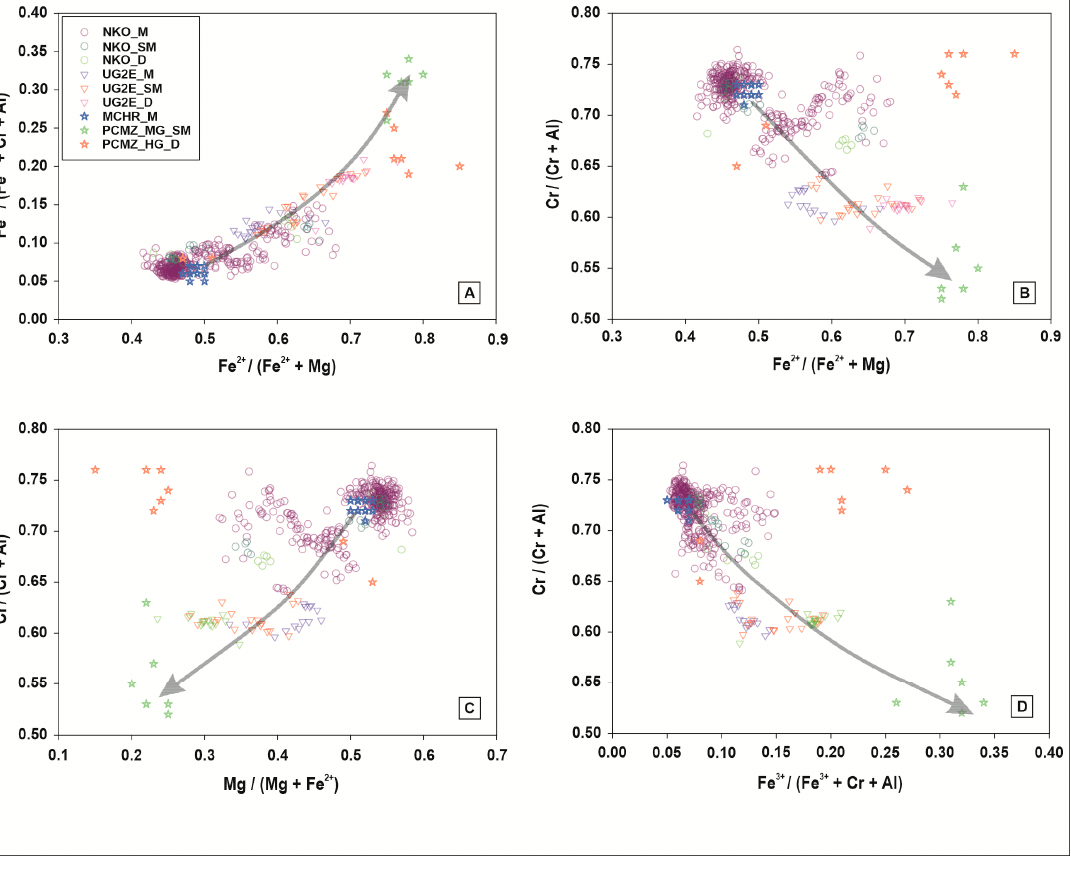
Figure 4. Binary diagrams of cation proportions in chromite. ( A ) Fe 2+ /(Fe 2+ + Mg) vs. Fe 3+/ (Fe 3+ + Cr + Al). ( B ) Fe 2+ /(Fe 2+ + Mg) vs. Cr/(Cr + Al). ( C ) Mg/(Mg + Fe 2+ ) vs. Cr/(Cr + Al). ( D ) Fe 3+ /(Fe 3+ + Cr + Al) vs. Cr/(Cr + Al). NKO represents data from [36]. UG2E represents data from [21]. The suffixes M, SM and D are abbreviations for massive, semi-massive and disseminated, respectively. The arrows represent change in chemistry from the massive to disseminated chromite.